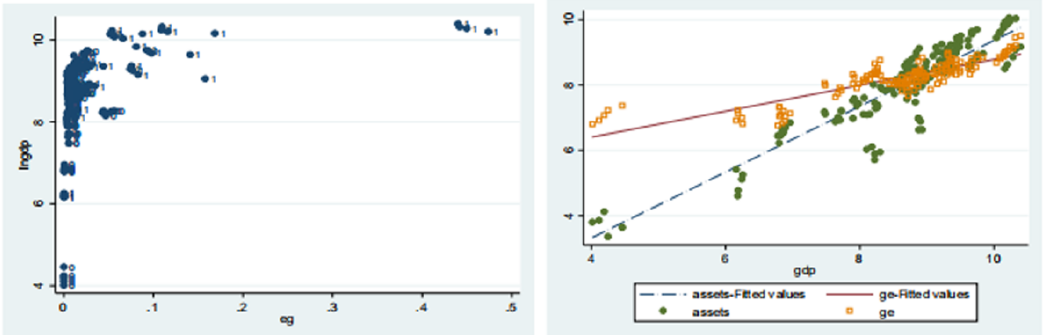
Fig. 1 Scatter point relationship between main